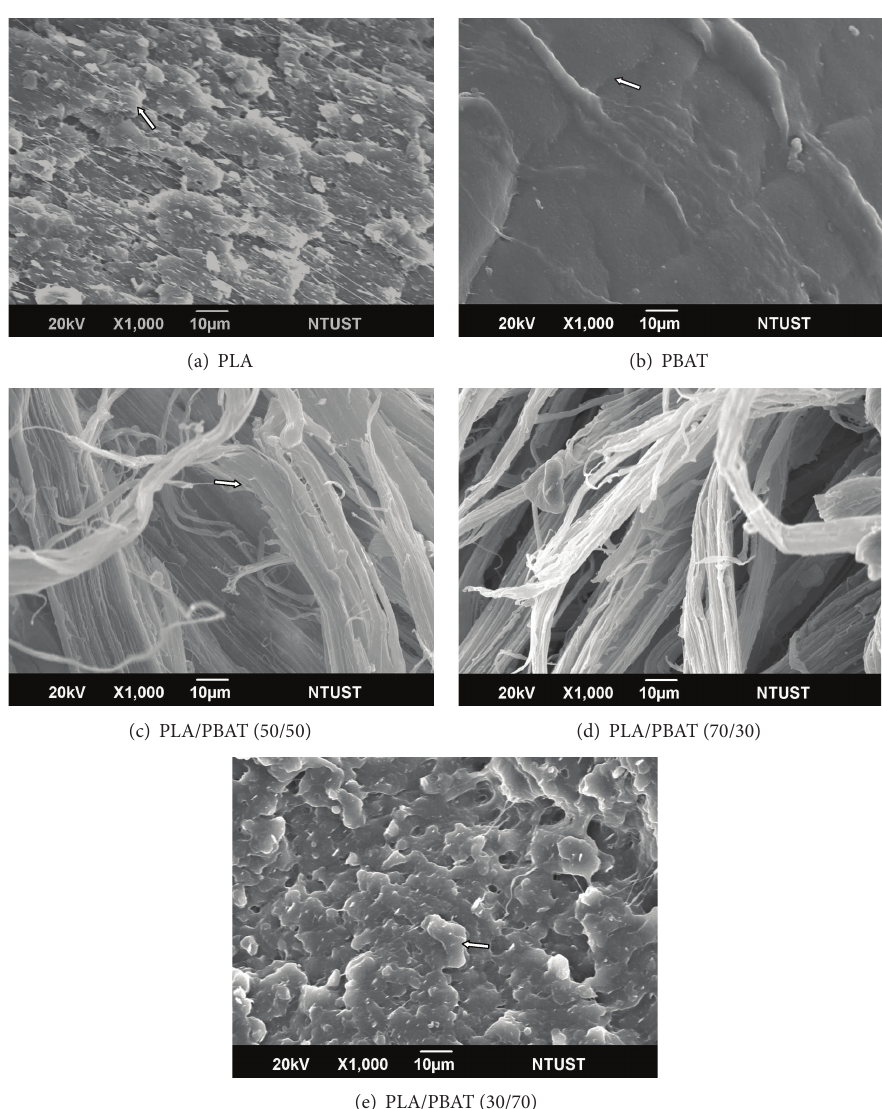
Figure 8: SEM graphs of break cross-section break on tensile testing at room temperature. The white arrows in (a–e) point to the break